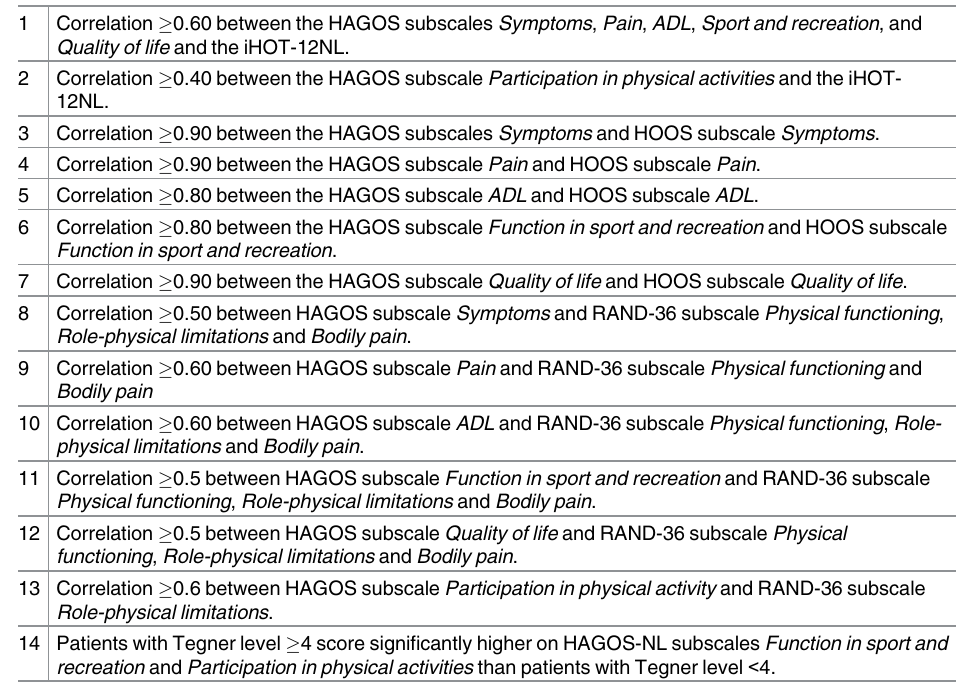
Table 1. Predefined and confirmed